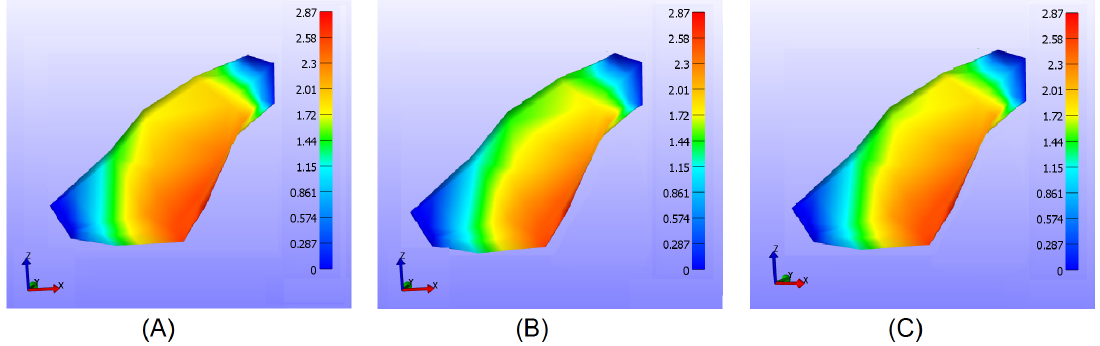
Figure 4. FEM based tissue model for the triceps. ( A ) shows the initial state of the tissue, ( B ) shows the muscle after being innervated, and ( C ) shows the muscle after the current is removed.